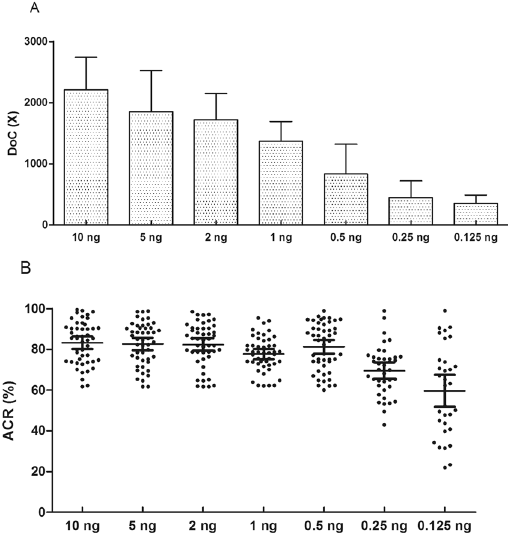
Figure 3. Sensitivity testing of series dilutions of control DNA 9948 from 10 ng to 0.125 ng. ( A ) Depth of coverage (Doc) of the seven dilutions; ( B ) averaged ACR values with 95% confidence interval for the 24 obtained heterozygous in the seven